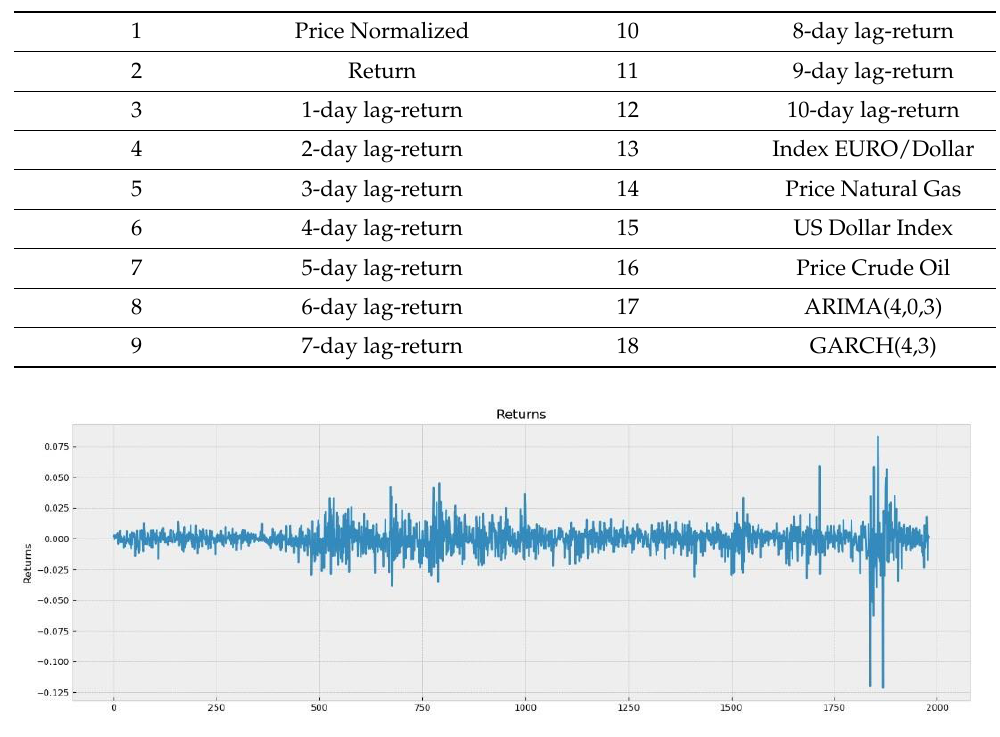
Figure 5. The daily return of Brent Crude Oil in the selected period.